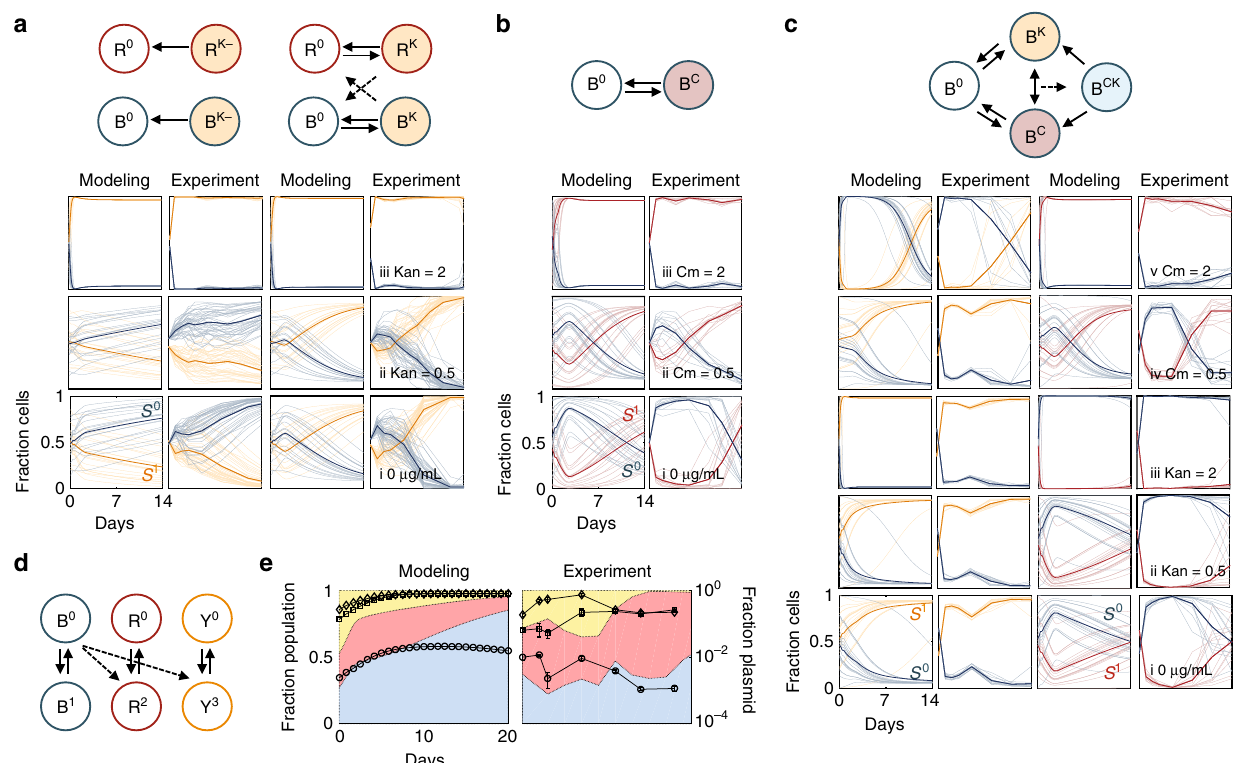
Fig. 3 Conjugation-assisted persistence with multiple species and/or plasmids. a – c x -axis is days and y -axis is fraction of cells. Bold and shaded lines represent average across, or individual, initial conditions, respectively. Color indicates blue for plasmid free ( S 0 ), and orange or red for plasmid-carrying cells ( S 1 ) K or C, respectively. a Two-species, one-plasmid community. Left two panels: no conjugation; right two panels: with conjugation. S 0 = B 0 + R 0 and S 1 = B K + R K . Modeling: From bottom (i) to top (iii) α = α = 1.02, 0.97, and 0.42, respectively, and α = 1.03, 1.02, and 0.9 (see Supplementary Eqs. (7) – 1 2 (10), Supplementary Fig. 4A). Experiment from bottom (i) to top (iii): Kan = 0, 0.5, and 2 μ g/mL, respectively. b Higher cost plasmid dynamics. Modeling (left column): From bottom (i) to top (iii) α = 1.13, 1.03, and 0.3, respectively (see Supplementary Eqs. (3) – (4), Supplementary Fig. 4B). Experiment (right column): From bottom (i) to top (iii): Cm = 0, 0.5, and 2 μ g/mL. c One species, two-plasmid community. Each row represents a different combination of α , modulated with no antibiotic (i), Kan (ii – iii), or Cm (iv – v). The species can carry two ( S 11 ), one ( S 10 , S 01 ), or no plasmids ( S 00 ). Modeling ( fi rst and third columns): From bottom (i) to top (v) α 3 = 1.3, 1.2, 0.42, 1.01, 0.35 (see Supplementary Eqs. (11) – (14), Supplementary Fig. 4B). Experiment: (second and fourth column such that S 1 = B K + B CK or S 1 = B C + B CK for K or C, respectively). B C is mixed equally with B K . d , e Three-species, three-plasmid community. Species (R, Y, and B) are uniquely fl uorescent (expressing dTomato, YFP, or BFP, respectively) and plasmids (R6K, RP4, and R388, diamond, square, and circle markers, respectively) have distinct resistance markers (Strp R , Kan R , and Tm R , respectively). Shading color corresponds to the respective population fraction (left y -axis), and markers indicate fraction of each plasmid (right y -axis). The initial experimental composition consists of R 0 , R R6K , Y 0 , Y R388 , B 0 , and B RP4 . Modeling (left): Randomized initial conditions such that the total plasmid-free populations is maintained at 1 × 10 − 4 , and plasmid population arbitrarily chosen between 1 × 10 – 5 and 1 × 10 6 , consistent with data (Supplementary Table 2 for parameter estimates). Experiment (right): Error bars indicate averaging across four-to-six plate replicates, and repeated fi ve